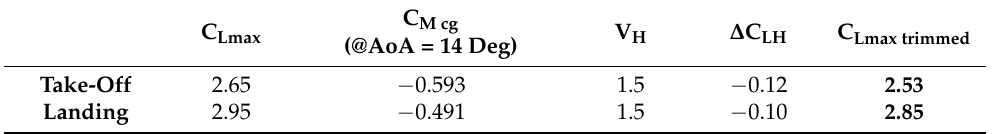
Table 14. Numerical results for low-speed conditions, trimmed maximum lift coefficient, moment coefficient calculated w.r.t. CG pos. (31% mac), M = 0.15, Re = 5.7 × 10 6 . C Lmax